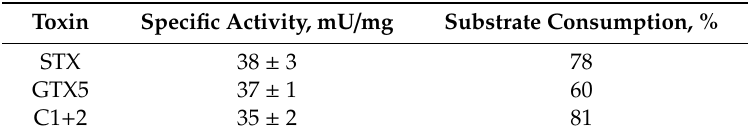
Table 2. Specific enzymatic activity towards STX, C1 + 2 and GTX5 of carbamoylase purified from crystalline style of S. solida and substrate consumption (after 1 h of incubation).